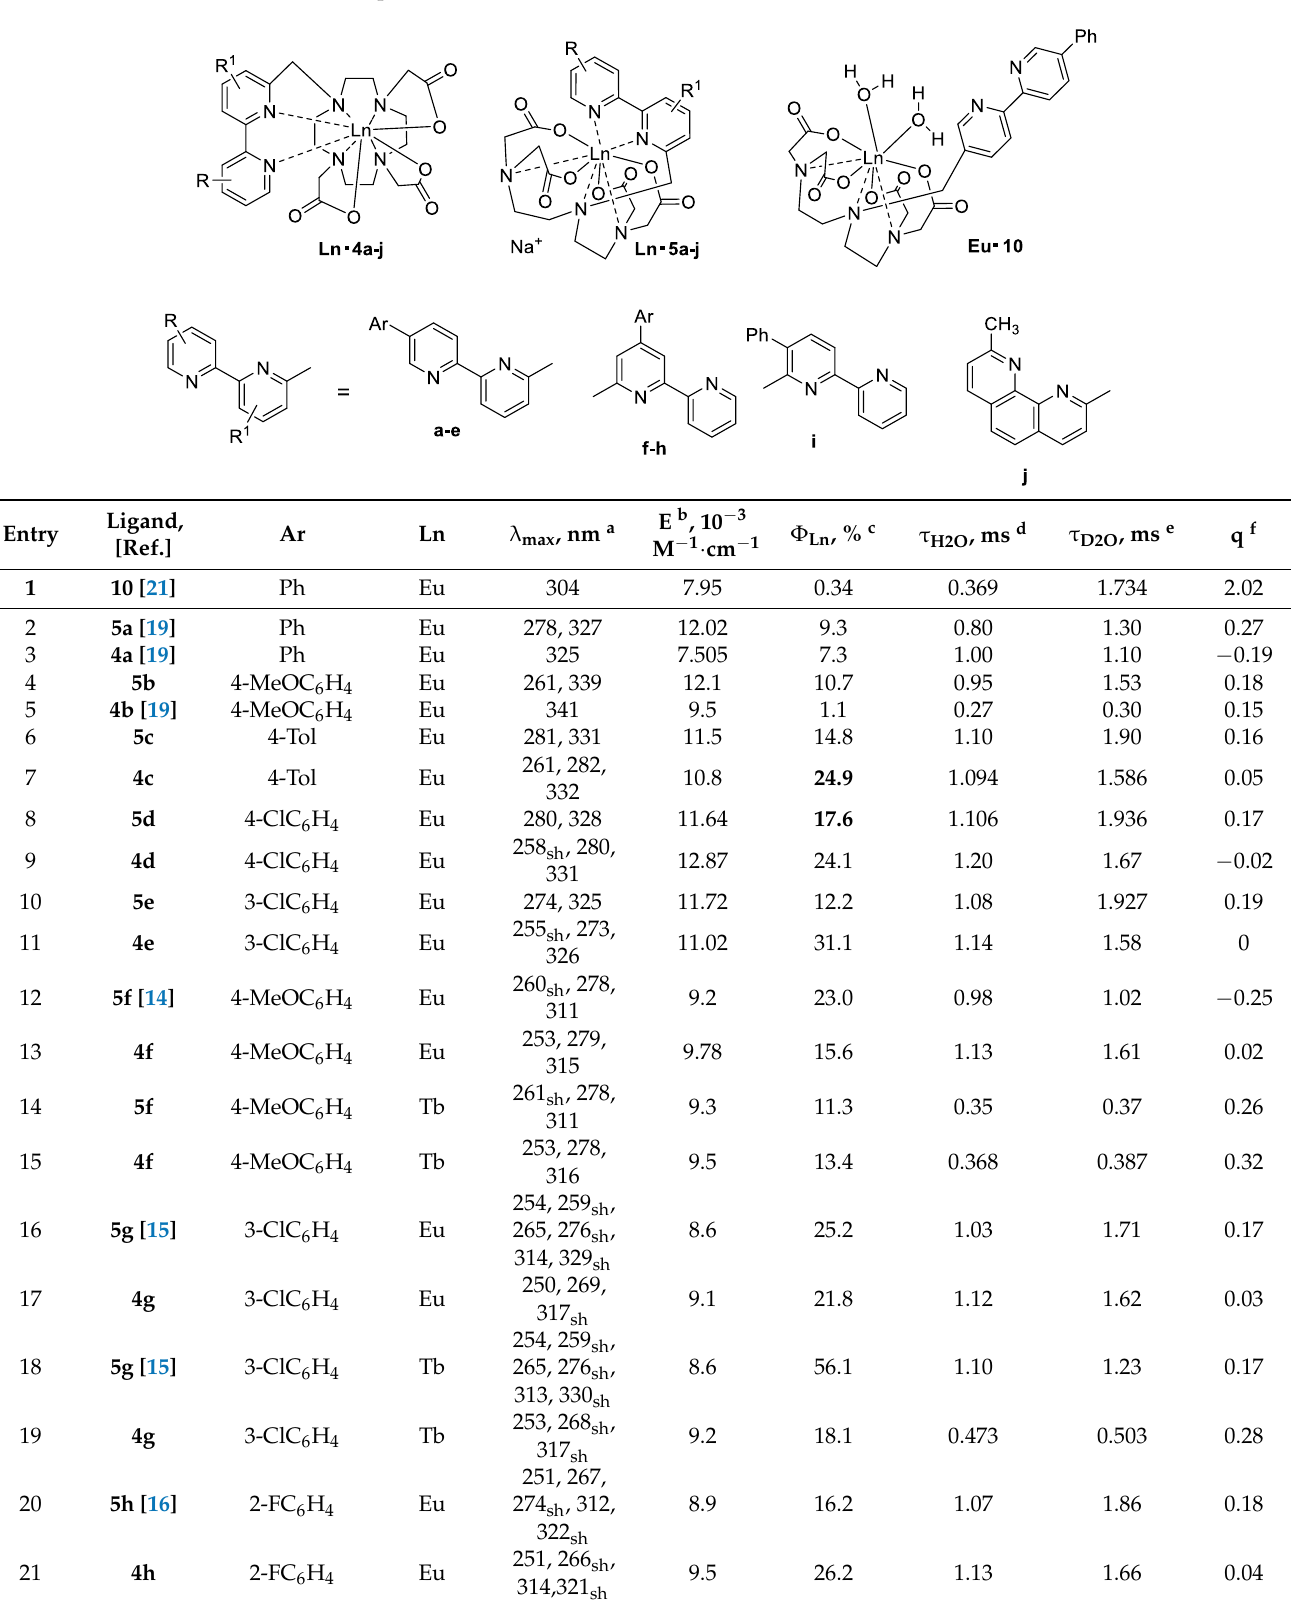
Table 1. Photophysical properties of new complexes of Ln•4,5,10 and previously published similar complexes.